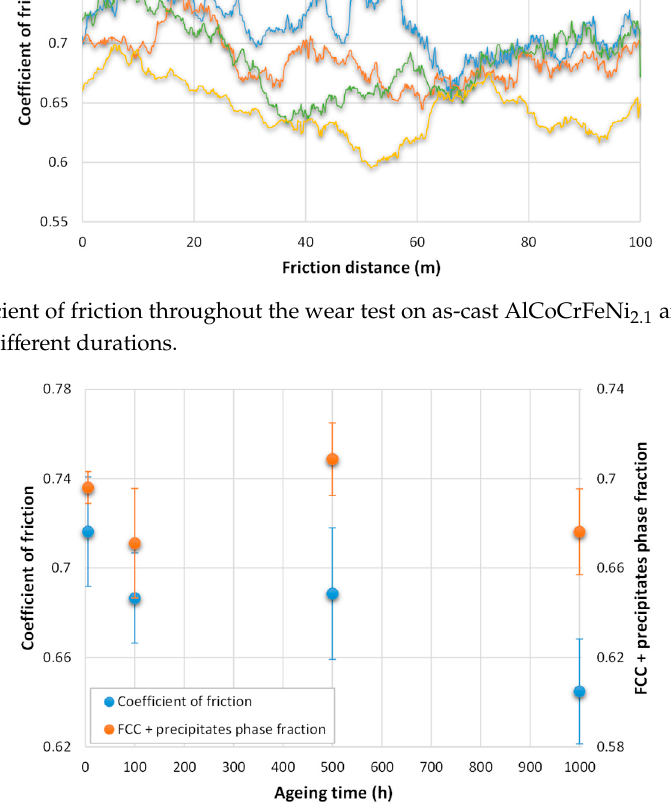
Figure 9. Coefficient of friction and FCC (L1 2 ) + precipitates phase fraction of as-cast AlCoCrFeNi 2.1 and after aging at 800 °C at three different durations.